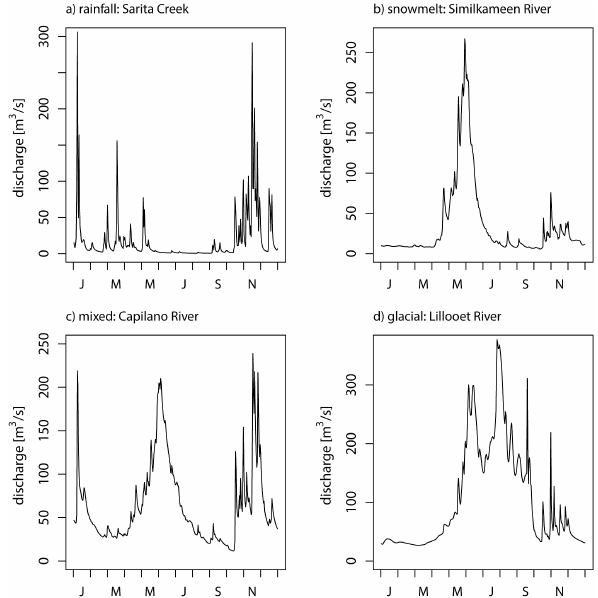
Figure 1. Selected examples illustrating the four main types of an- nual hydrographs found in the Coast Mountains of British Columbia and Yukon as described by Eaton and Moore